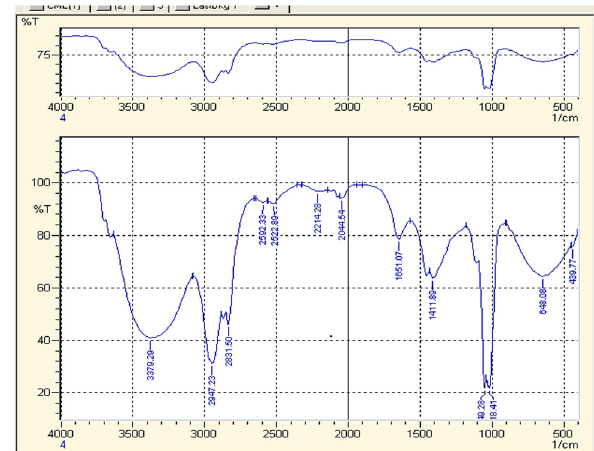
Figure 5: FTIR spectrum of crude water extract of Tropaoelum majus .